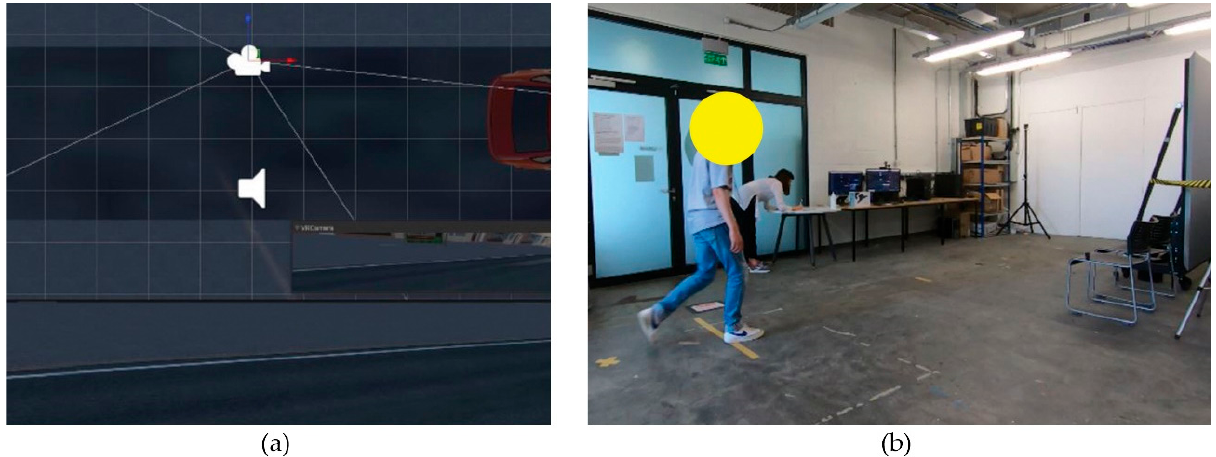
Figure 3. ( a ) Crossing initiation in the virtual environment and ( b ) in the physical environment. Participant walks past the yellow line marked on the floor initiating the crossing. Additional floor markings are in place to designate the end of the crossing space.